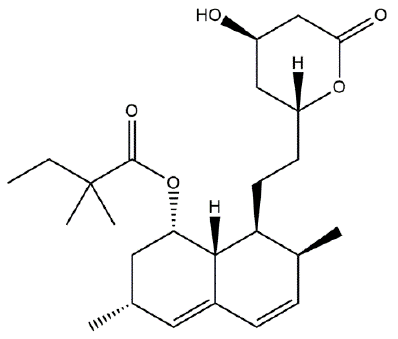
Figure 3. Schematic representation of simvastatin’s chemical structure.